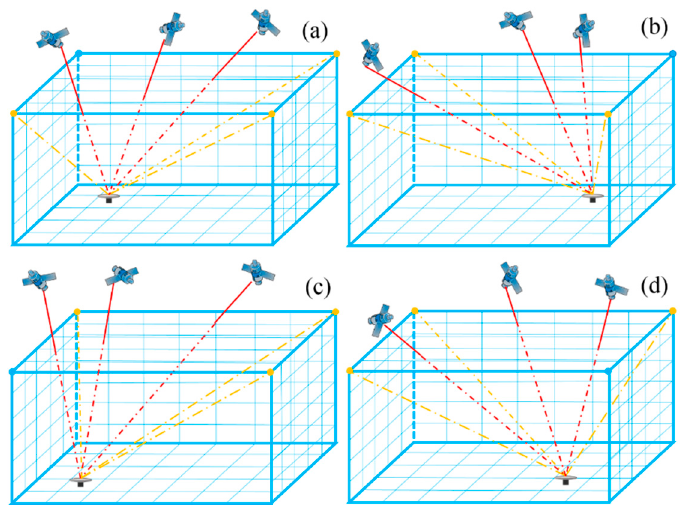
Figure 1. 3-D distribution of slant water vapor and virtual slant water vapor. ( a – d ) represent the GNSS receiver located in four different tomographic regions, namely northwest, northeast, southwest, and southeast.